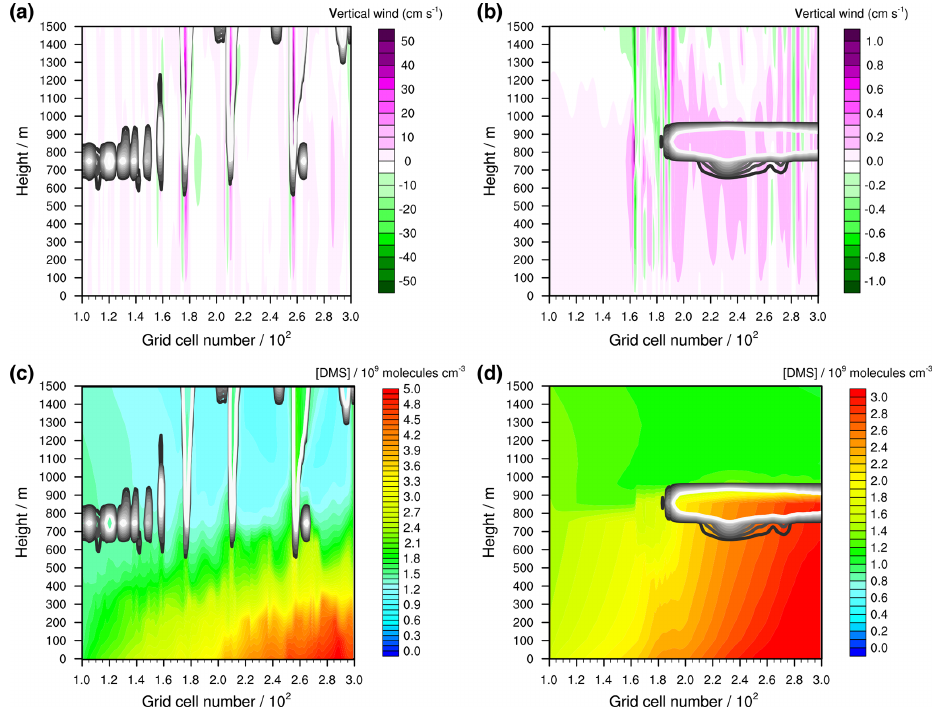
Figure 7. Modelled vertical winds (cms − 1 ) (a) in the unstable meteorological condition simulation with convective clouds and (b) in the stable meteorological condition simulation with stratiform clouds after 12h of modelling time. The x axis represents the innermost horizontal grid cells divided by 100. The black contour lines represent the simulated clouds. The black line corresponds to a LWC of 0.01gm − 3 and the white line to 0.1gm − 3 . The area framed by the white line includes LWC above 0.1gm − 3 . Further, the modelled concentrations of DMS in the gas phase (10 9 moleculescm − 3 ) are shown in (c) for the unstable meteorological condition simulation with convective clouds and in (d) for the stable meteorological condition simulation with stratiform clouds after 12h of modelling time.